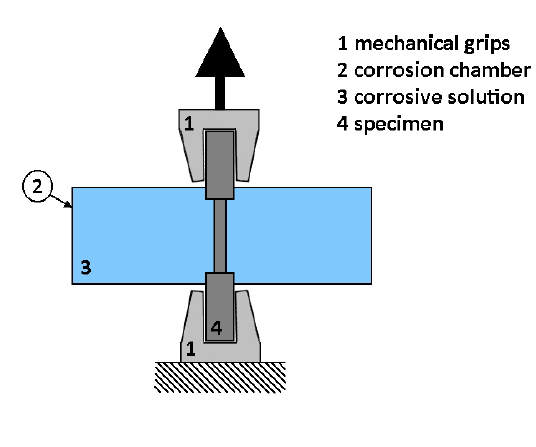
Figure 2. Schematic representation of the SSRT set up.